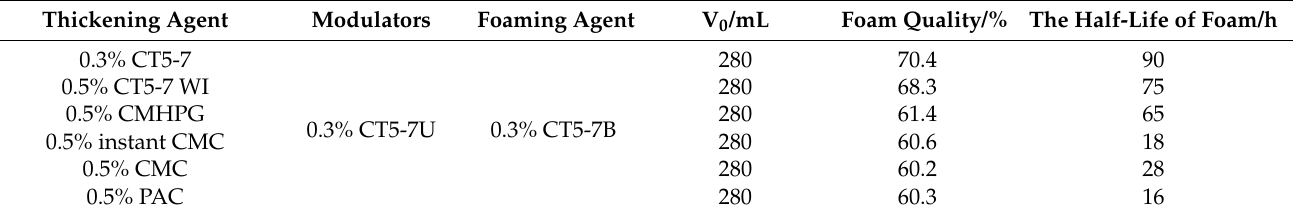
Table 2. Experimental results of thickening agent foam